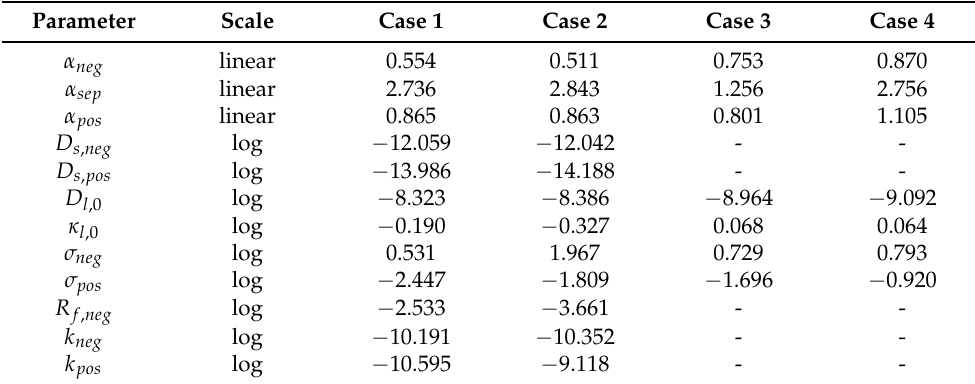
Table 6. Summary of the parameter values selected for the validation